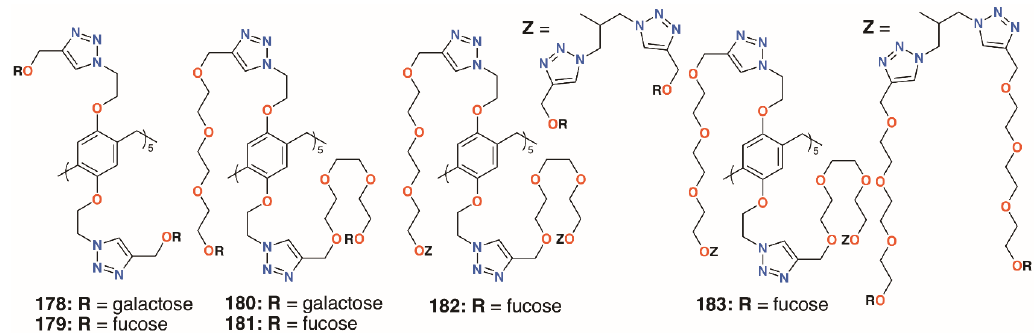
Figure 29. Nierengarten’s glycosylated pillararenes.